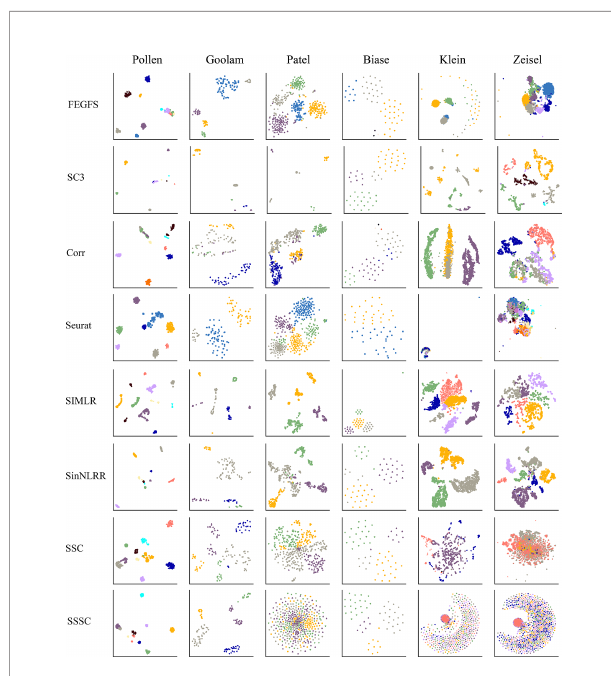
FIGURE 3 | The t-distributed stochastic neighbor embedding (t-SNE) visualization of cells on six real single-cell RNA sequencing (scRNA-seq) datasets using different clustering methods.